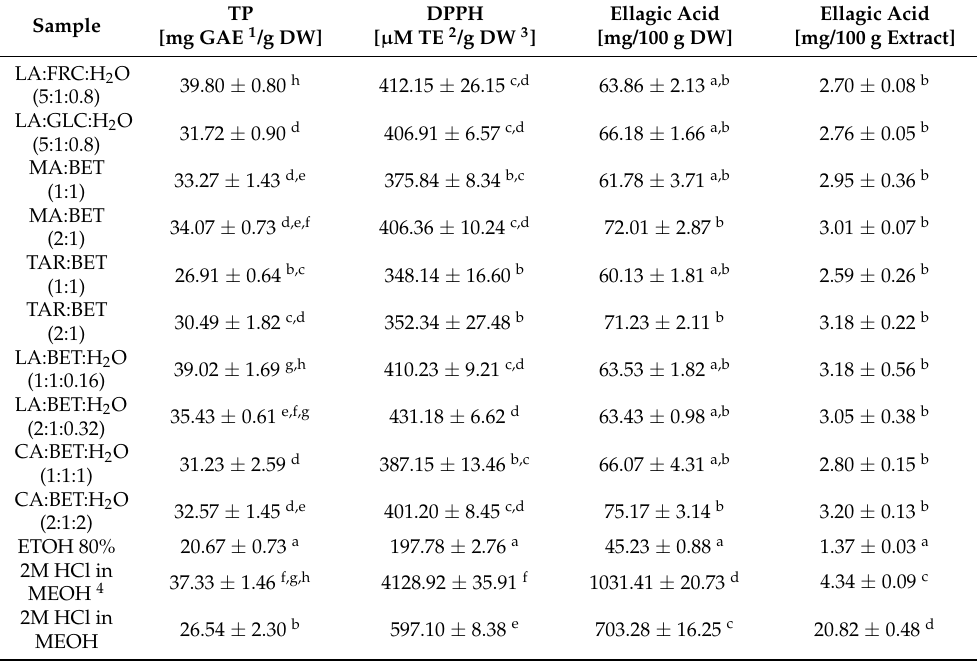
Table 1. Total polyphenol (TP) content, antioxidant activity, and ellagic acid content obtained by NADES, 80% ethanol solution, and acidified methanol solutions. Extractions were performed at 60 ◦ C for 30 min with 20 g/g of NADES/plant ratio in a water bath placed on a magnetic stirrer hot